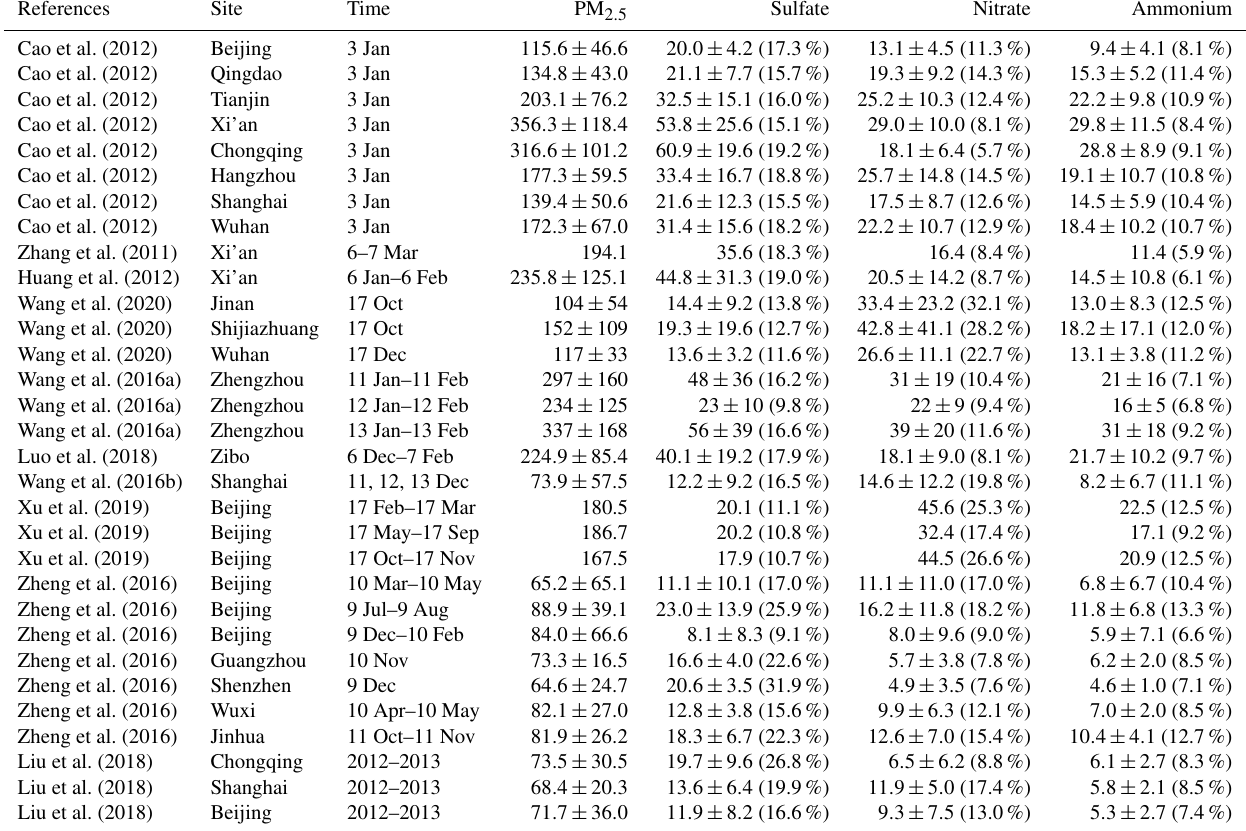
Table 4. The reported concentrations of PM 2 . 5 and the three inorganic salts (sulfate, nitrate, and ammonium, in µg / m 3 ) in other